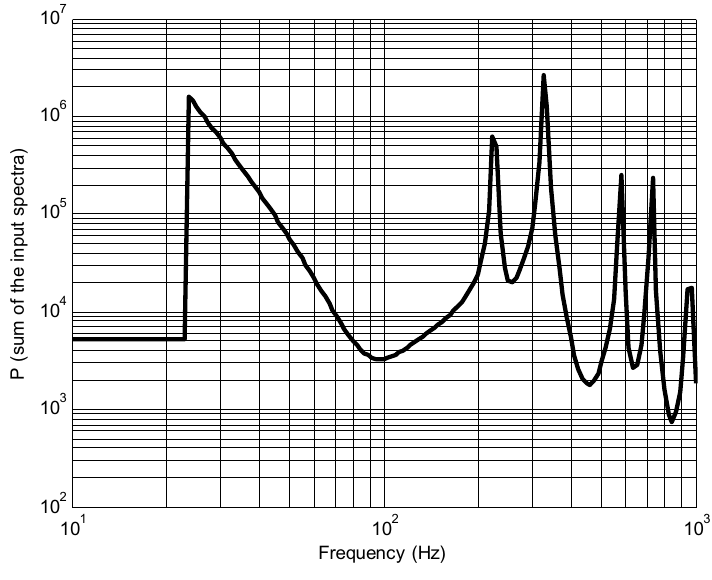
Fig. 8. Example 1, Trace of the input spectral